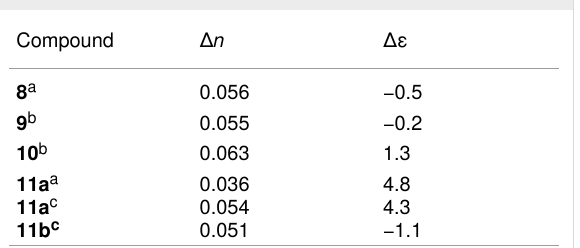
Table 2: Physical properties of compounds 8 – 11